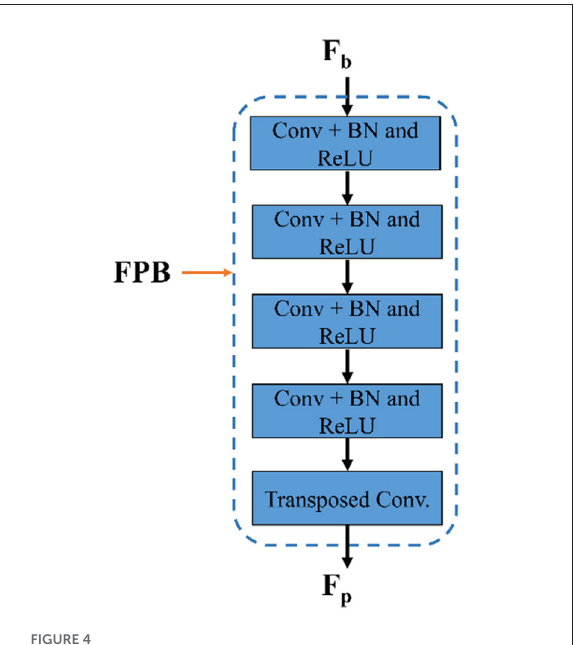
FIGURE4 The structure of feature preserving block.